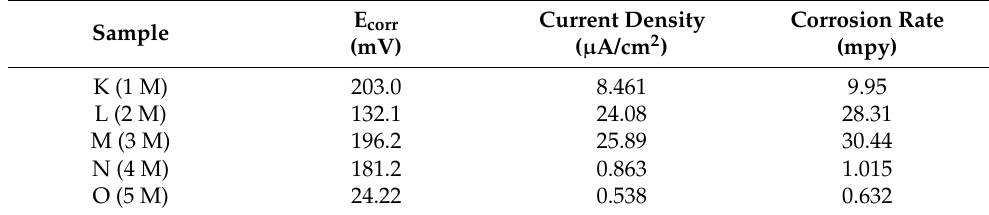
Table 3. E corr , current density, and corrosion rate at 12 V and variations in sulfuric acid concentration. E corr Current Sample